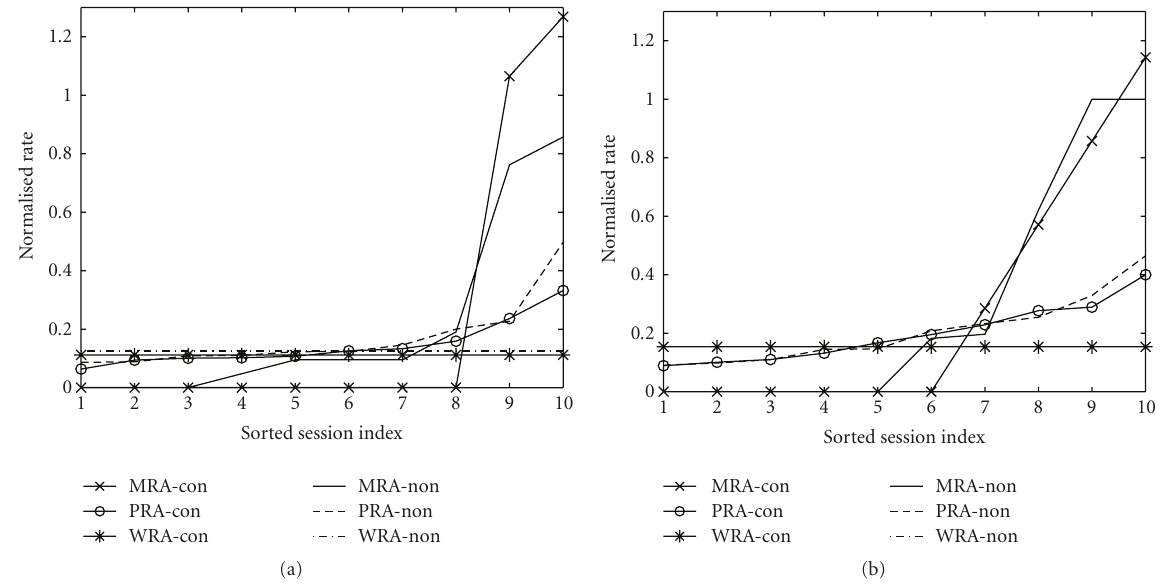
Figure 5: Rate allocation results for the experimented sessions: (a) L = 1, and (b) L = 10.